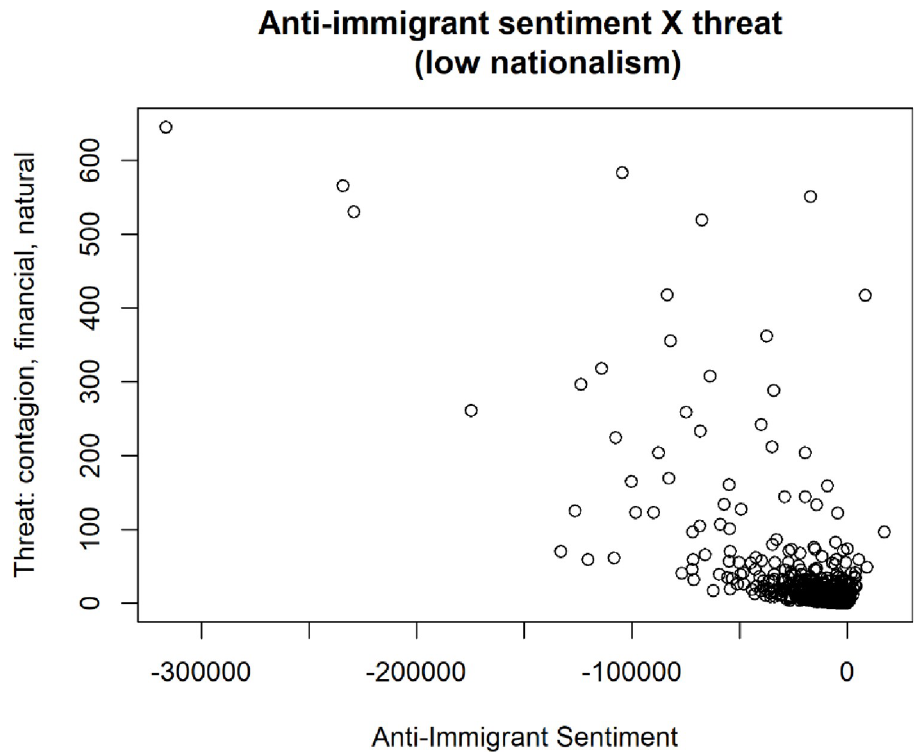
Fig 23. Levels of antiimmigrant sentiment and threat for low nationalism